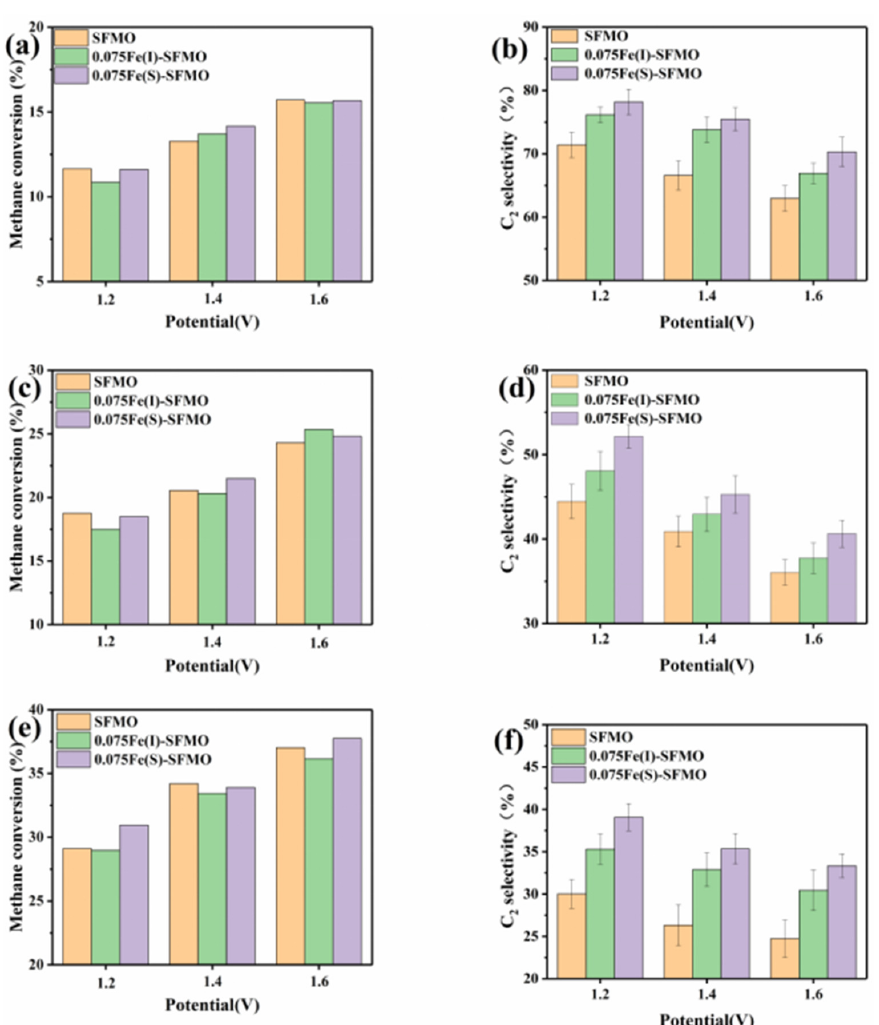
Figure 9. The performance of methane oxidative coupling. CH 4 conversion ( a ) and C 2 selectivity ( b ) at the rate of 0.3 L min −1 ; CH 4 conversion ( c ) and C 2 selectivity ( d ) at the rate of 0.2 L min −1 ; CH 4 at the rate of 0.3 L min − 1 ; CH 4 conversion ( c ) and C 2 selectivity ( d ) at the rate of 0.2 L min − 1 ; CH 4 conversion ( e ) and C 2 selectivity ( f ) at the rate of 0.1 L min −1 . conversion ( e ) and C 2 selectivity ( f ) at the rate of 0.1 L min − 1